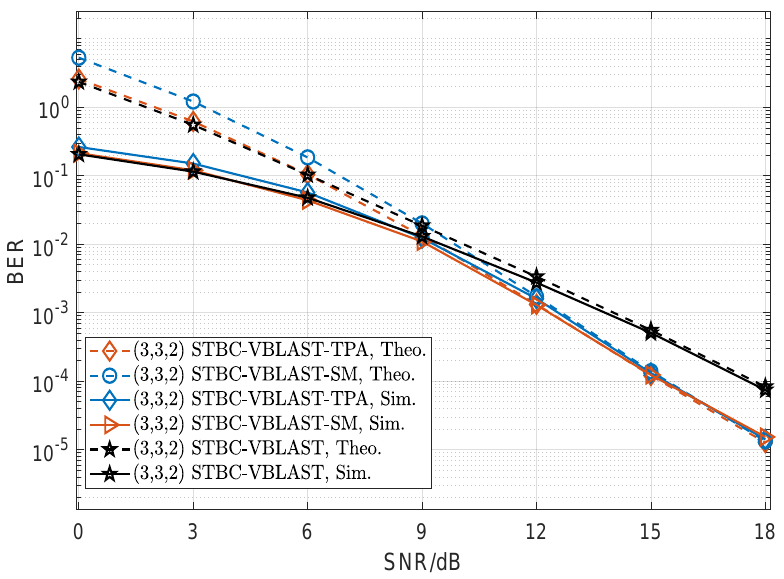
Figure 11. Performance comparisons of the ( 3,3,2 ) STBC-VBLAST-SM system, STBC-VBLAST-TPA system and traditional STBC-VBLAST system, where 4.5 bits/s/Hz for the STBC-VBLAST-SM system and 4 bits/s/Hz for the STBC-VBLAST-TPA and STBC-VBLAST